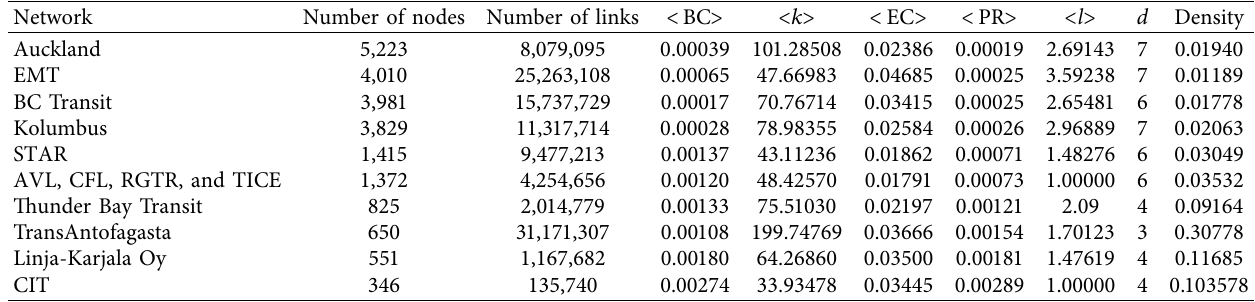
Table 5: Structural properties in P-Space. Average Betweenness Centrality ( < BC > ), average degree ( < k > ), average Eigenvector Centrality ( < EC > ), average PageRank (with a damping factor � 0.85) ( < PR > ), average path Length ( < l > ), diameter ( d ), and density.